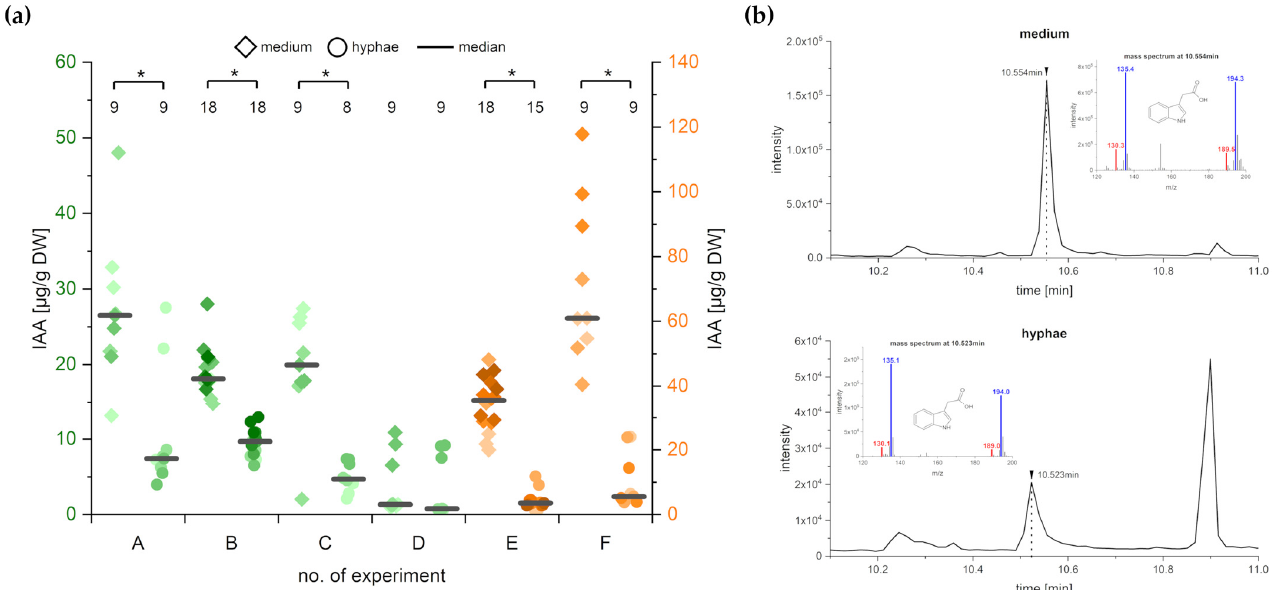
Figure 3. Amount of IAA in medium and hyphae of C. asteris in in vitro cultures. C. asteris was cultivated in MEAlow medium at 23 °C and 130 rpm in the dark for 10 days. ( a ) IAA levels in medium and hyphae of C. asteris in different experiments (A–F). Experiments A to D are shown with the left y-axis, experiments E and F are shown with the right y-axis. Data were analyzed using an unpaired t-test with Welch correction (test statistics can be found in Table S1). Significant differences between medium and hyphae are labeled with an asterisk. Sample size n is given in the upper part below the asterisks. ( b ) Extracted ion chromatogram of IAA ( m / z 130) from medium and hyphae samples of C. asteris , including mass spectra (MS) at the specific retention times (red: MS data of IAA; blue: MS data of the internal standard D 5 -IAA).